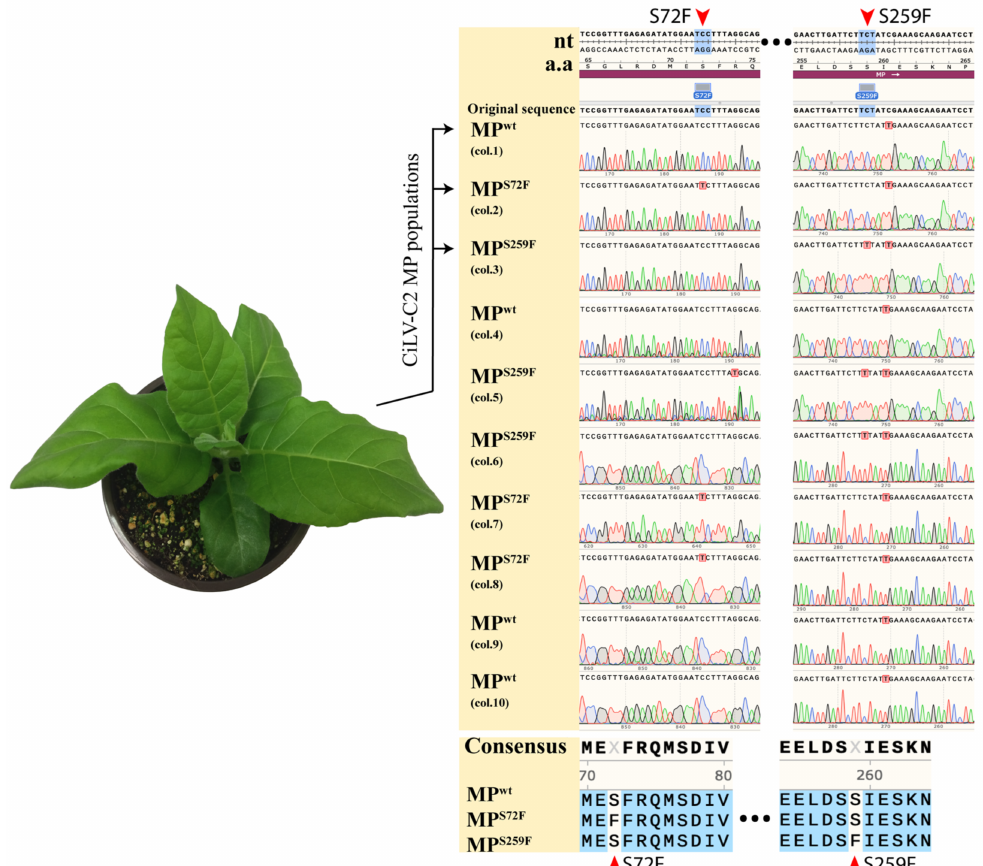
Figure 3. CiLV-C2 MP variants recovered from P12 plant in viral fitness study. P12 plant infected with the AMV population expressing the CiLV-C2 MP is visualized at the left of the figure. P12 images are representative of 18 infected plants. At the right of the figure is presented chromatograms from ten clones recovered from the P12 plant at the second viral passage. The exchange of serines for phenylalanines at positions 72 (MP S72F ) and 259 (MP S259F ) is highlighted by red arrows. Below the chromatograms are displayed amino acids consensus sequences of MPs revealing mutations 72 (MP S72F ) and 259 (MP S259F ) highlighted by red arrows. Chromatograms and sequence alignment were performed using the software SnapGene v.